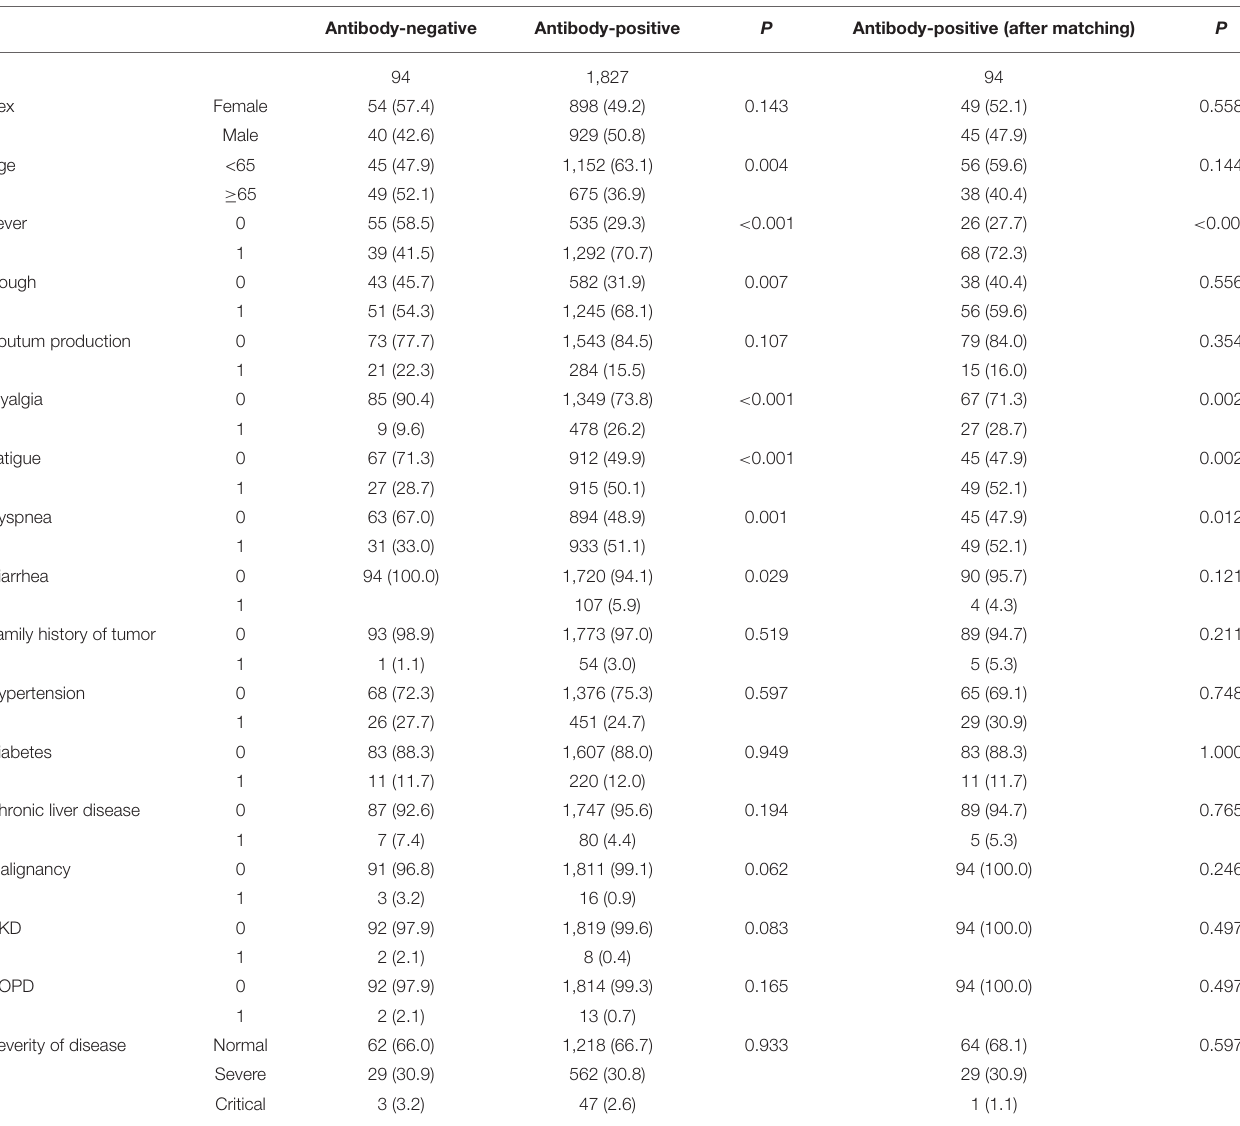
TABLE 1 | Baseline characteristics of patients with COVID-19. Antibody-negative Antibody-positive P Antibody-positive (after